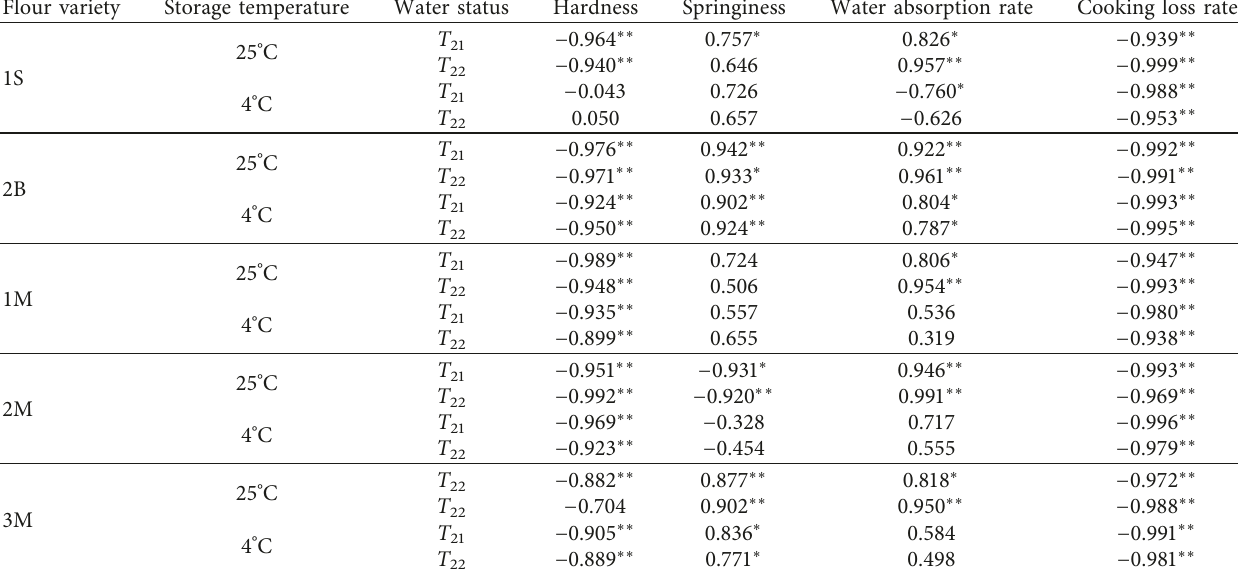
Table 6: Correlation analysis between moisture and quality indicators of wheat flour. Flour